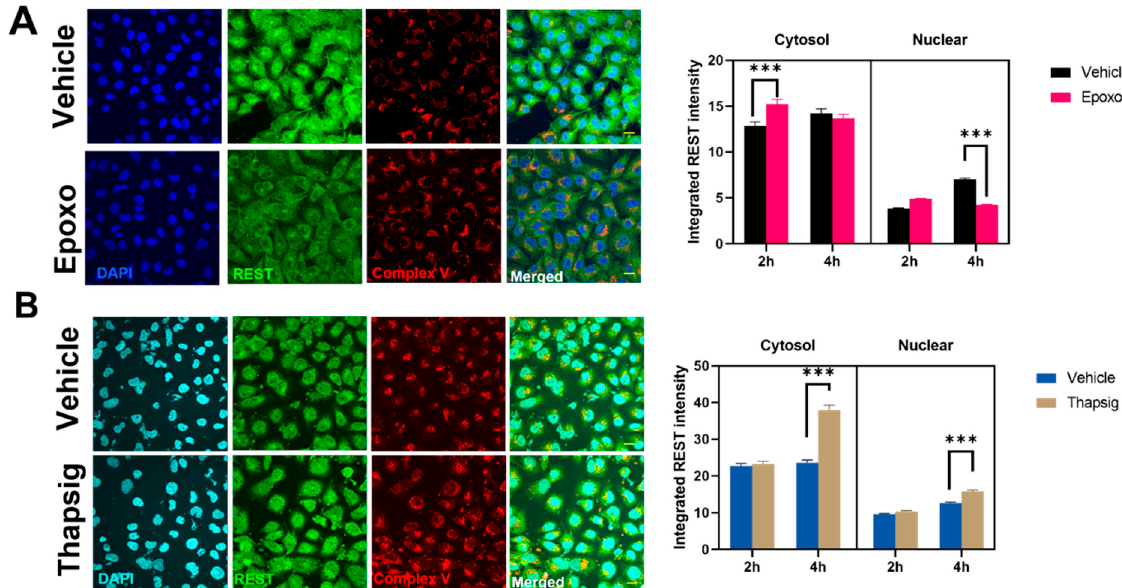
Figure 6. ER and proteasome stress induces changes in the levels of REST and its colocalization with the mitochondrial epitopes. Representative confocal microscopy images of HMEC cells immunostained with antibodies against REST, and the mitochondrial complex V showing the diverse effects of proteasome stress ( A ) and ER stress ( B ) ( n = 365–559 different cells). Images shown are for 2 h of incubation. In the graphs on the right, the bars indicate the mean with the standard deviation shown by lines. *** Indicates p < 0.001 by Sidak’s post-hoc multiple comparison test after a 2-way ANOVA. The bars in the ( A , B ) micrographs are 40 micrometer long.